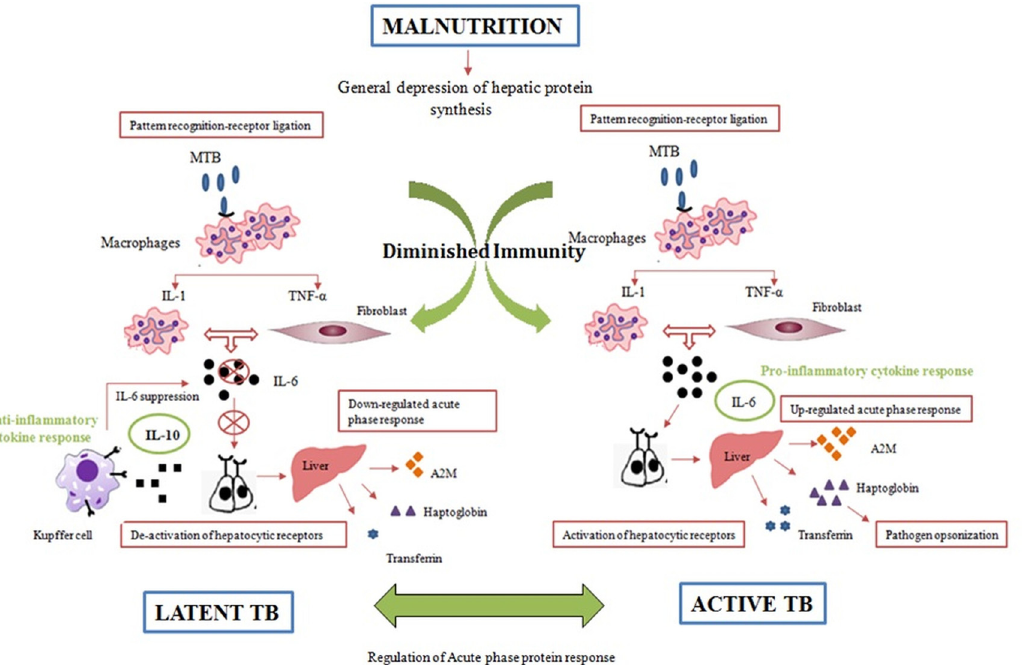
Fig 7. Mechanisms involved in the acute phase protein response in malnutrition and TB. Malnutrition and the anorectic effects of pro-inflammatory cytokines in the brain result in a negatively changed hepatic synthesis. In diseased condition, the pro-inflammatory cytokines TNF- α , IL-1 and IL-6 play a key role in the hepatic APR. They activate hepatocytic receptors, and synthesis of varying APPs starts. During latent form of infection, release of IL-10 by the Kupffer cells results in suppression of the local IL-6 production by gene suppression pathways coactivated on receptor binding. This results in rapid hepatic removal of circulating cytokines followed by down-regulation of hepatocytic